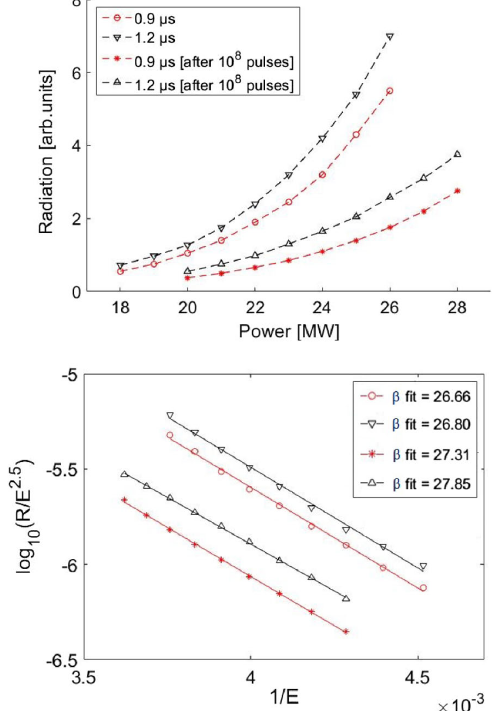
m.FIG. 14. Dependence of faraday cups signals on power during conditioning (top) and the fit to the Fowler-Nordheim formula (bottom).